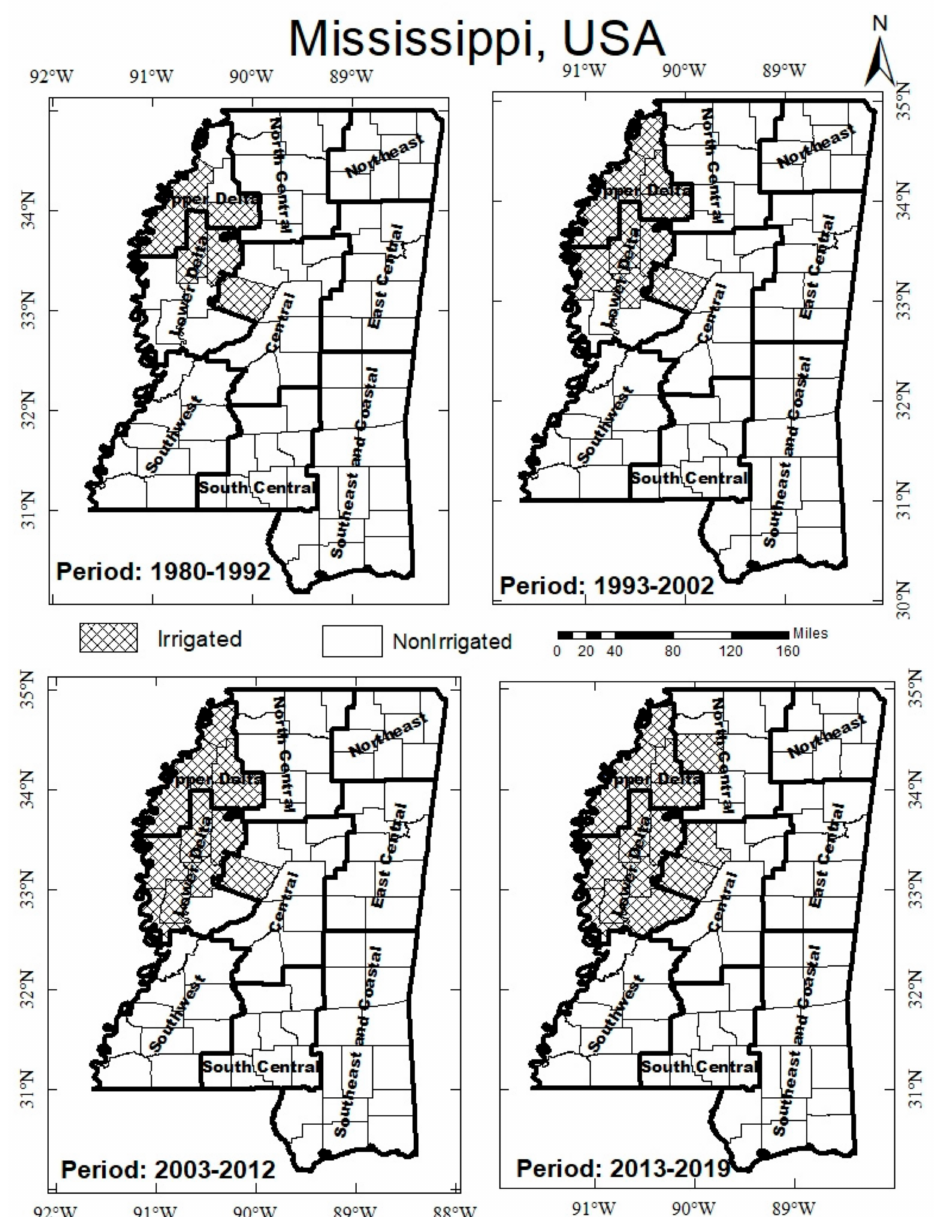
Figure 1. The irrigated and non–irrigated zones in Mississippi, USA from 1980 to 2019. Nine agricultural districts categorized by